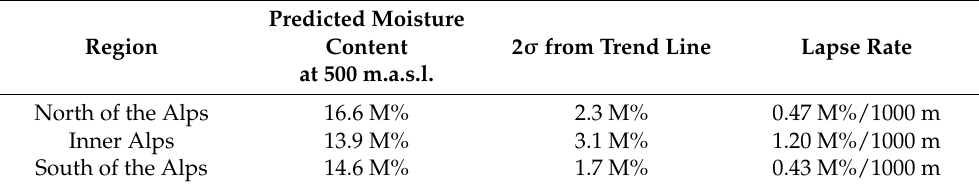
Table 3. Summary of predicted moisture content for the three different